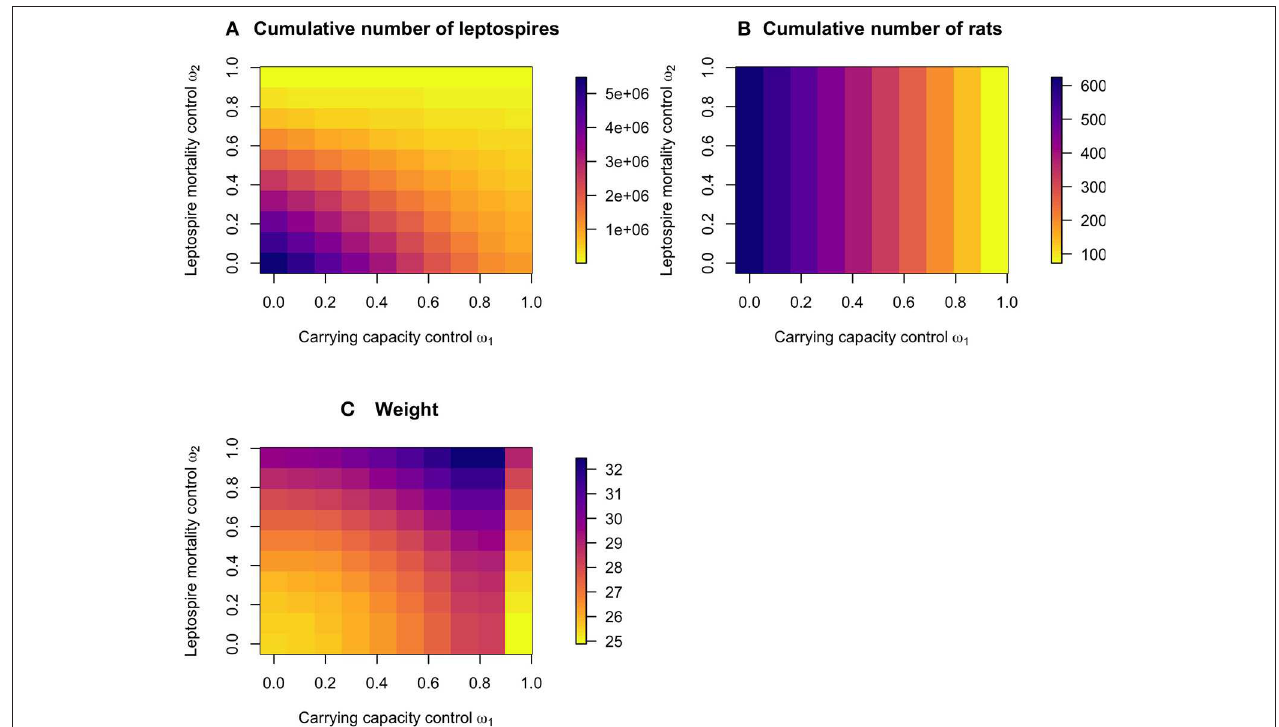
FIGURE 3 | The predicted effect of the permanent and temporary controls on (A) the cumulative number of leptospires on the log10 scale, and (B) the cumulative number of rats over the 600 days period, with (C) the associated cumulative weights of the control measures.